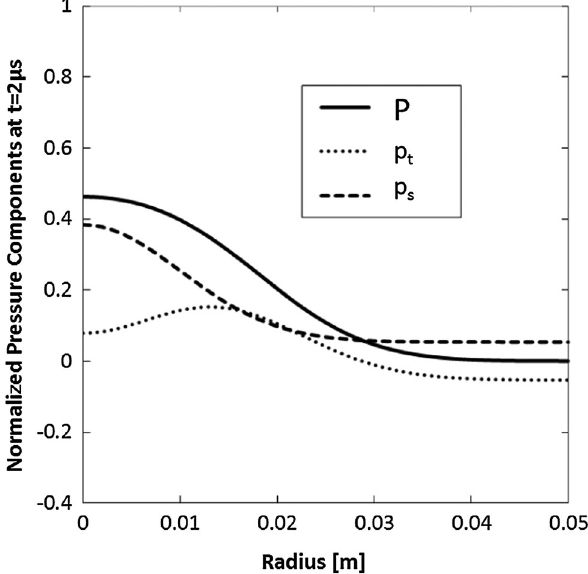
FIG. 11. Propagation of transient component of pressure for the test case assuming plane